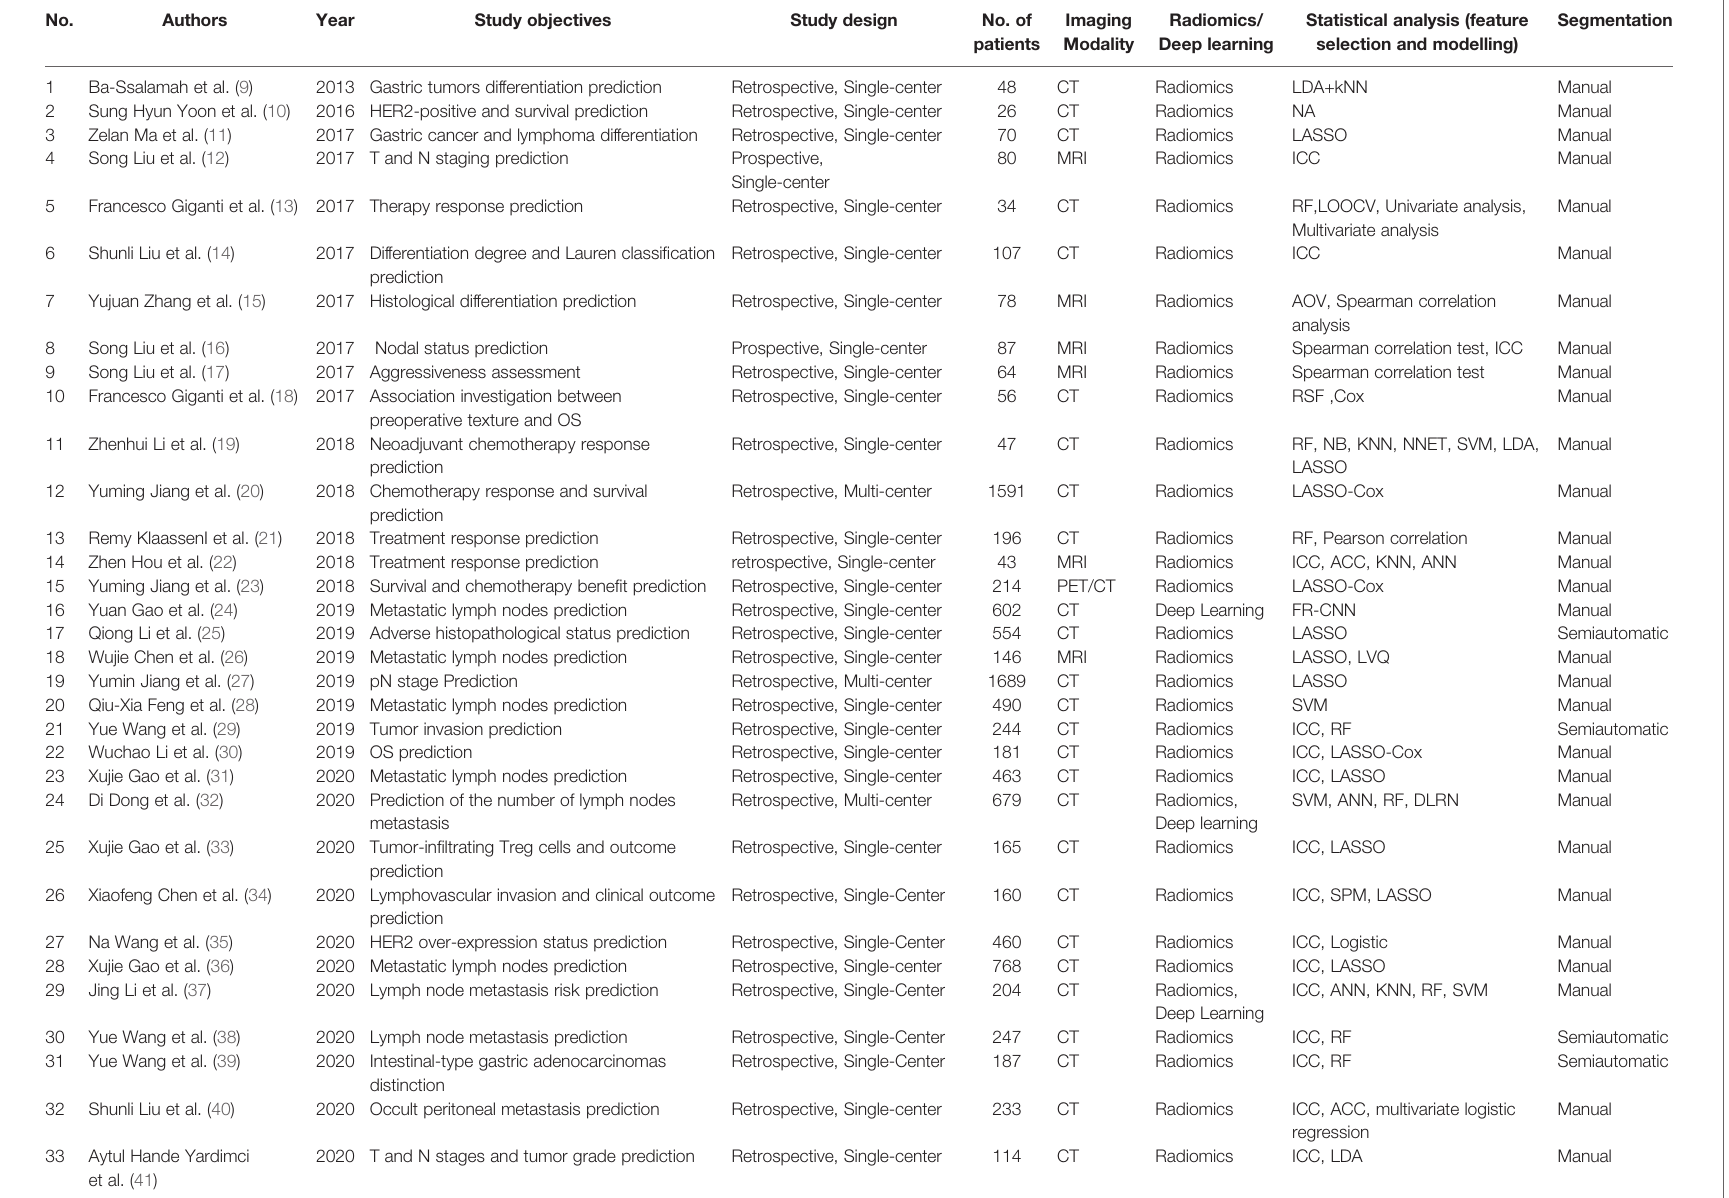
TABLE 1 | Summary of published hand-crafted radiomics and deep learning studies on gastric cancer